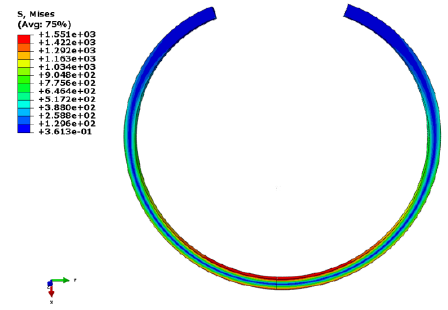
Fig. 6. View of the state of stress in the tension ring exemplary engine EMD